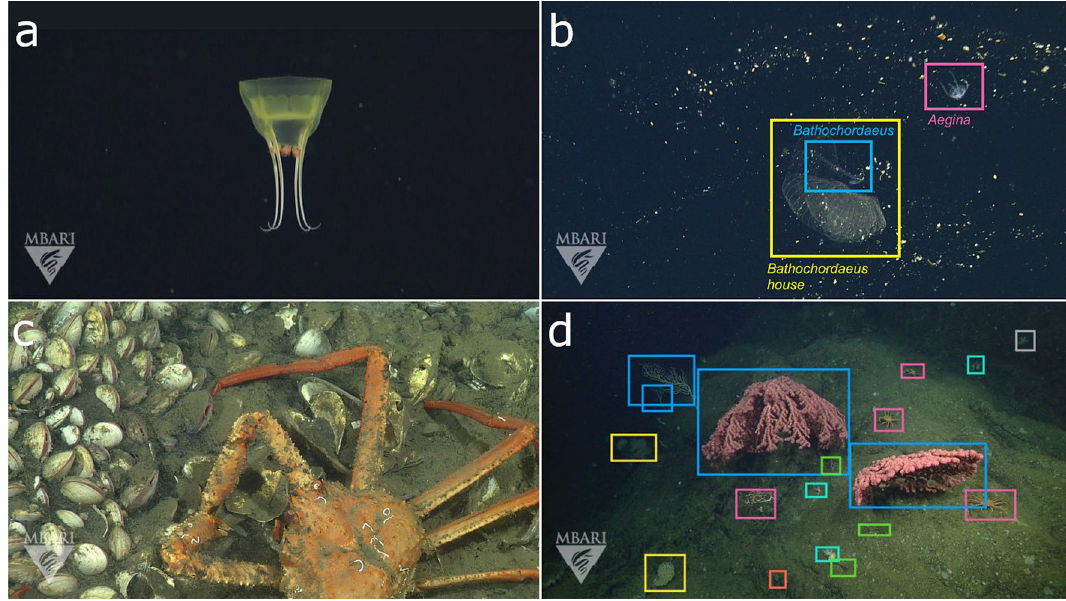
Figure 1. Labeled image data for deep learning algorithms require an annotation and localization for a single concept. Images showing the disparity between ( a , c ) traditionally annotated visual data in MBARI’s VARS database and ( b , d ) the level of annotations and localizations (or bounding boxes) that are required for the data science community. Top ( a , b ) and bottom ( c , d ) rows show images for midwater and benthic environments, respectively. ( a , b ) and ( c , d ) are example images from VARS that have been assigned a single-concept annotation for the genuses Aegina ( b , pink) and Chionoecetes ( d , pink), respectively. Although images in the left column ( a , c ) are largely iconic views of a single-concept, images in the right column ( b , d ) show non-iconic views of multiple concepts that additionally include ( b ) Bathochordaeus (blue), Bathochordaeus house (yellow), ( d ) Paragorgia (blue), Asteroidea (pink), Psolus (cyan), Pandalopsis (green), Heterochone (yellow), and Tunicata (red). Label text has been removed for clarity in ( d